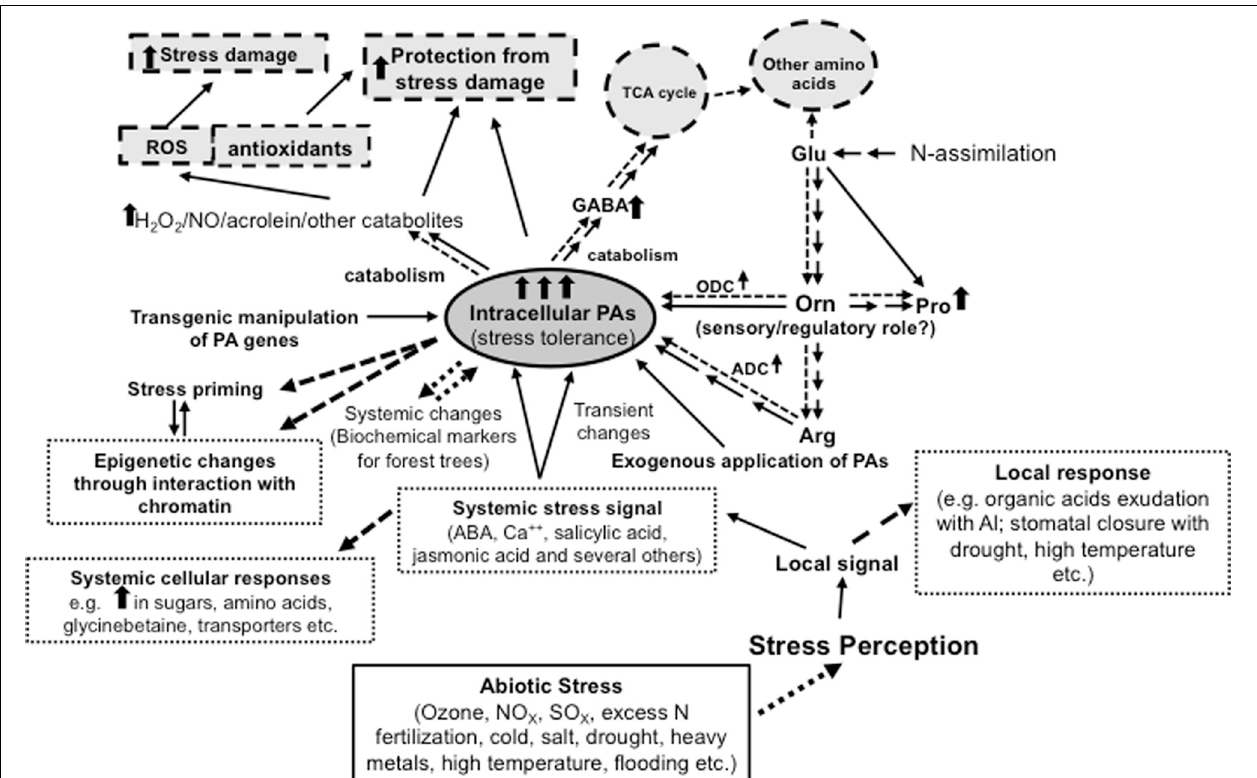
FIGURE 1 | Diagrammatic representation of the complexity of interactions between polyamines and abiotic stress response in plants. The Figure also shows a central role of ornithine in the metabolic interaction of polyamines with glutamate, proline, arginine